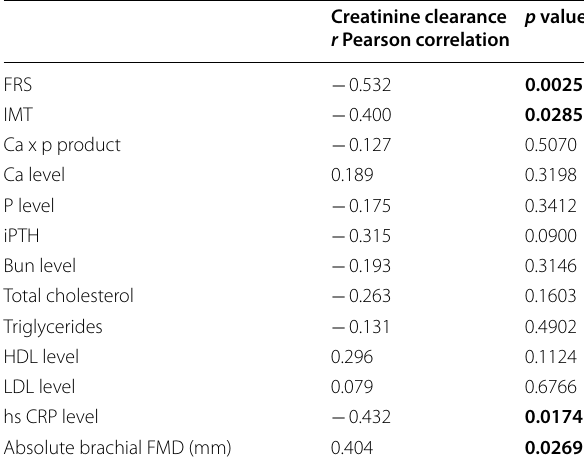
FRS Framingham risk score, IMT intimal medial thickness, Ca calcium, P phosphorus, iPTH intact parathyroid hormone, BUN blood urea nitrogen, HDL high-density lipoprotein, LDL low-density lipoprotein, Hs CRP high-sensitivity c-reactive protein, FMD flow-mediated dilatation mm